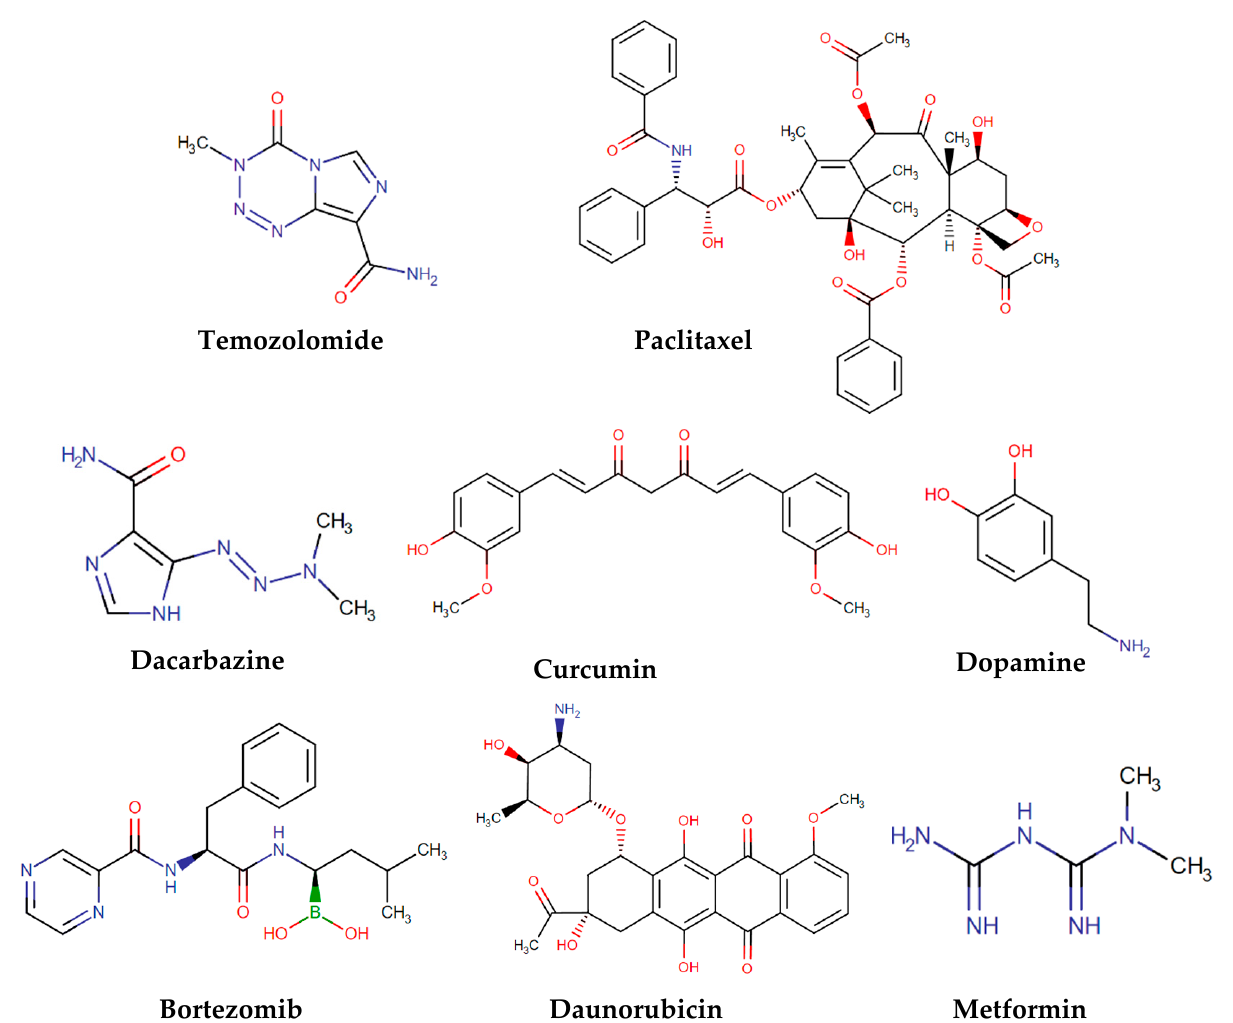
Figure 3. Chemical structures of the released drugs in drug delivery systems [80].